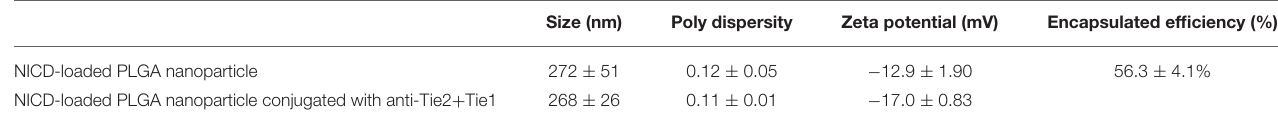
TABLE 3 | NICD plasmid loaded PLGA nanoparticle characteristics.